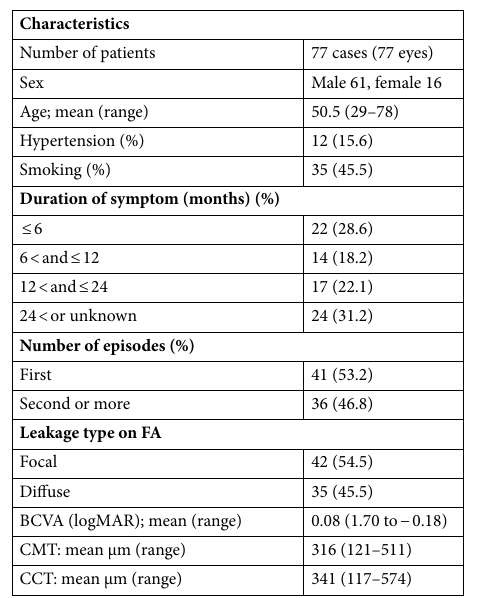
Table 1. Patient characteristics at baseline. FA : fluorescein angiography; BCVA : best corrected visual acuity; logMAR : logarithm of the minimum angle of resolution; CMT : central macular thickness; CCT : central choroidal